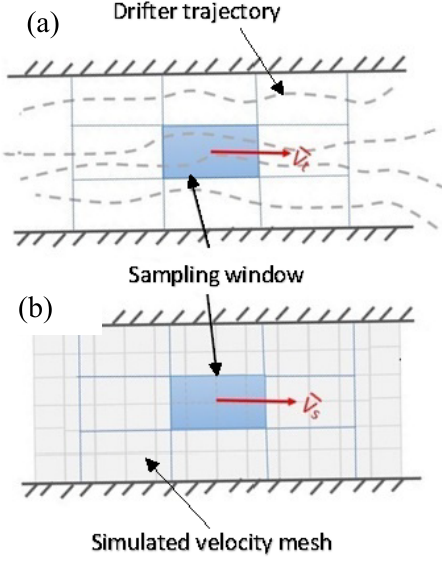
Figure 11. Schematic spatio-temporal window of the domain. Grey dashed lines show the schematic drifter trajectories. The velocity arrow (V l ) in ( a ) denotes the mean velocity of drifters inside each cell, while the velocity arrow (Vs) in ( b ) denotes the mean simulated velocity obtained from the model in the same time frame.